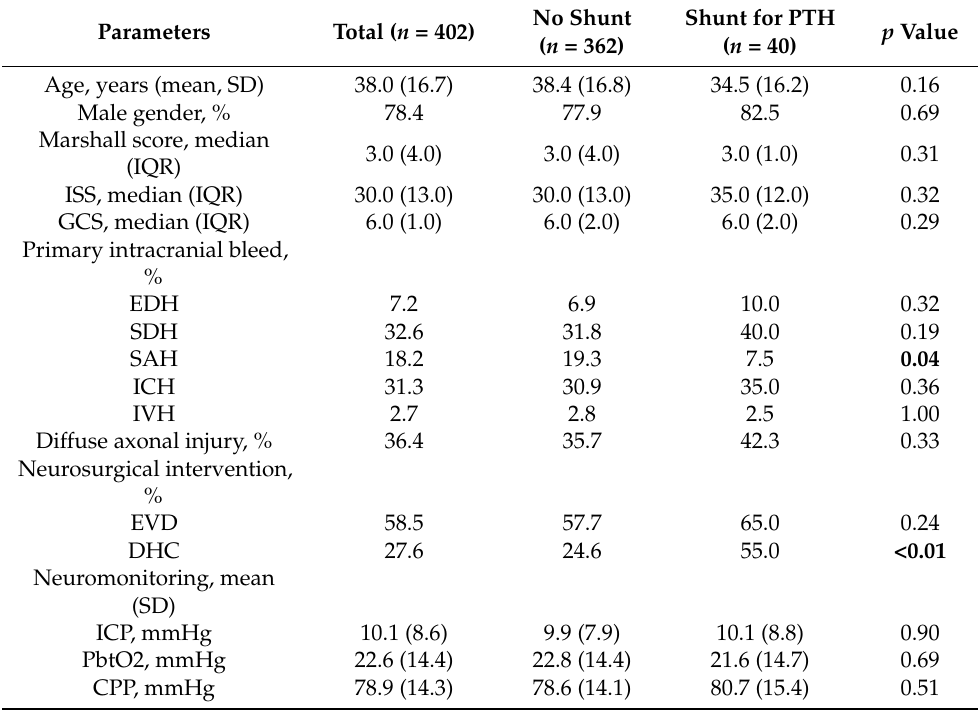
Table 1. Baseline demographics and clinical characteristics of severe TBI